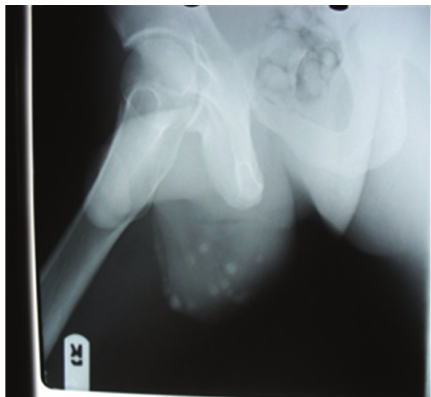
Figure 5: Two weeks